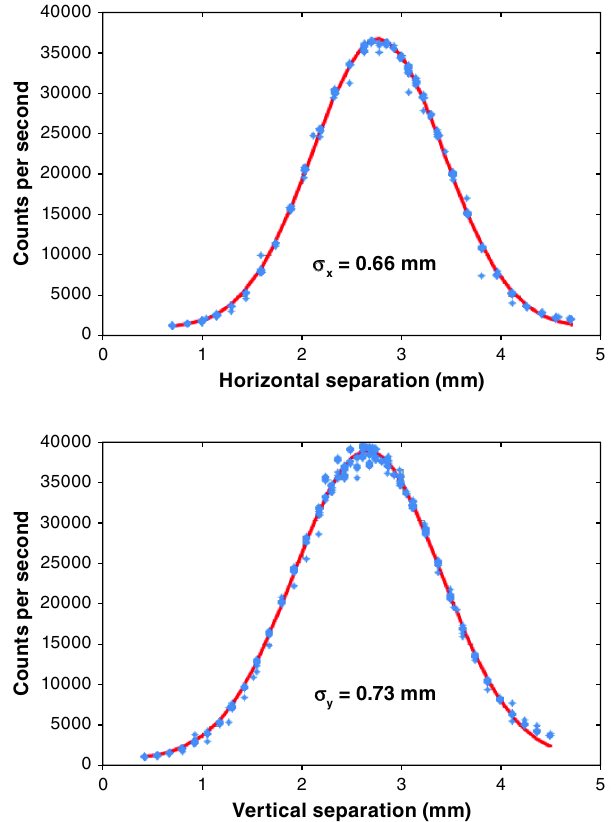
FIG. 9. Finite element stress analysis results for the 25 . 4 × 6 . 9 × 0 . 1 mm 3 Ti-6Al-4V alloy window. There is a safety factor of 3.9 at atmospheric pressure. The window was pressure tested up to three atmospheres without bursting.